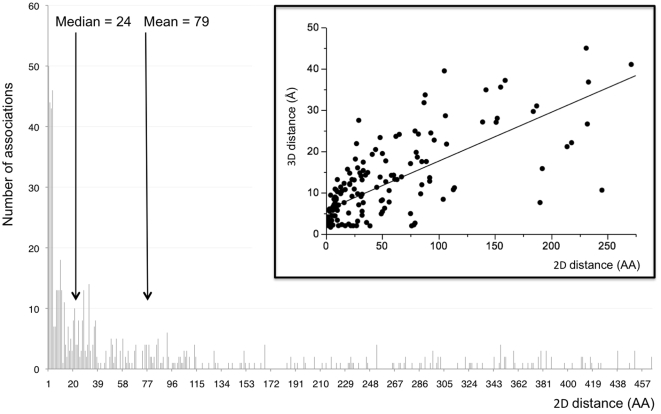
Distances between co-varying residues.The larger graph shows the distribution of the 2D distances between all the pairs of co-varying AA in Gag. The inset represents the relationship between the 2D and 3D distances.